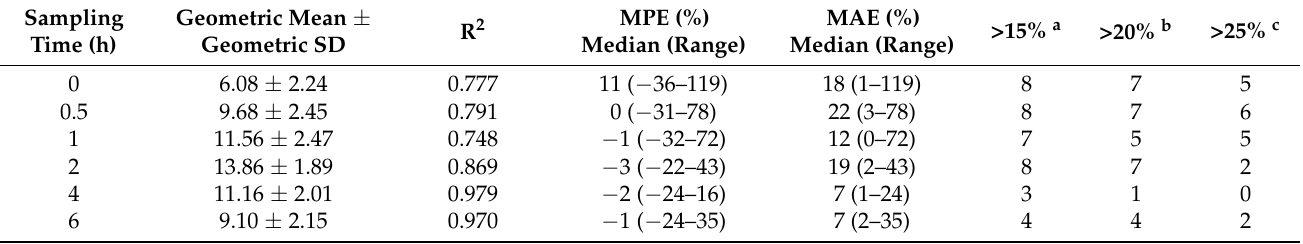
Table 3. The predictive performance of the single-point sampling strategy for AUC 0–12h